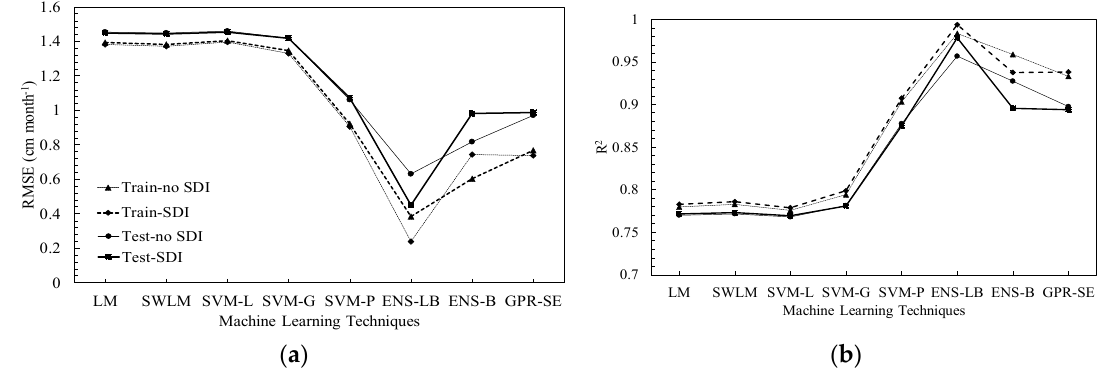
Figure 10. Performance of proposed models including RMSE ( a ) and R 2 ( b ) for prediction of grass-covered soil drainage.